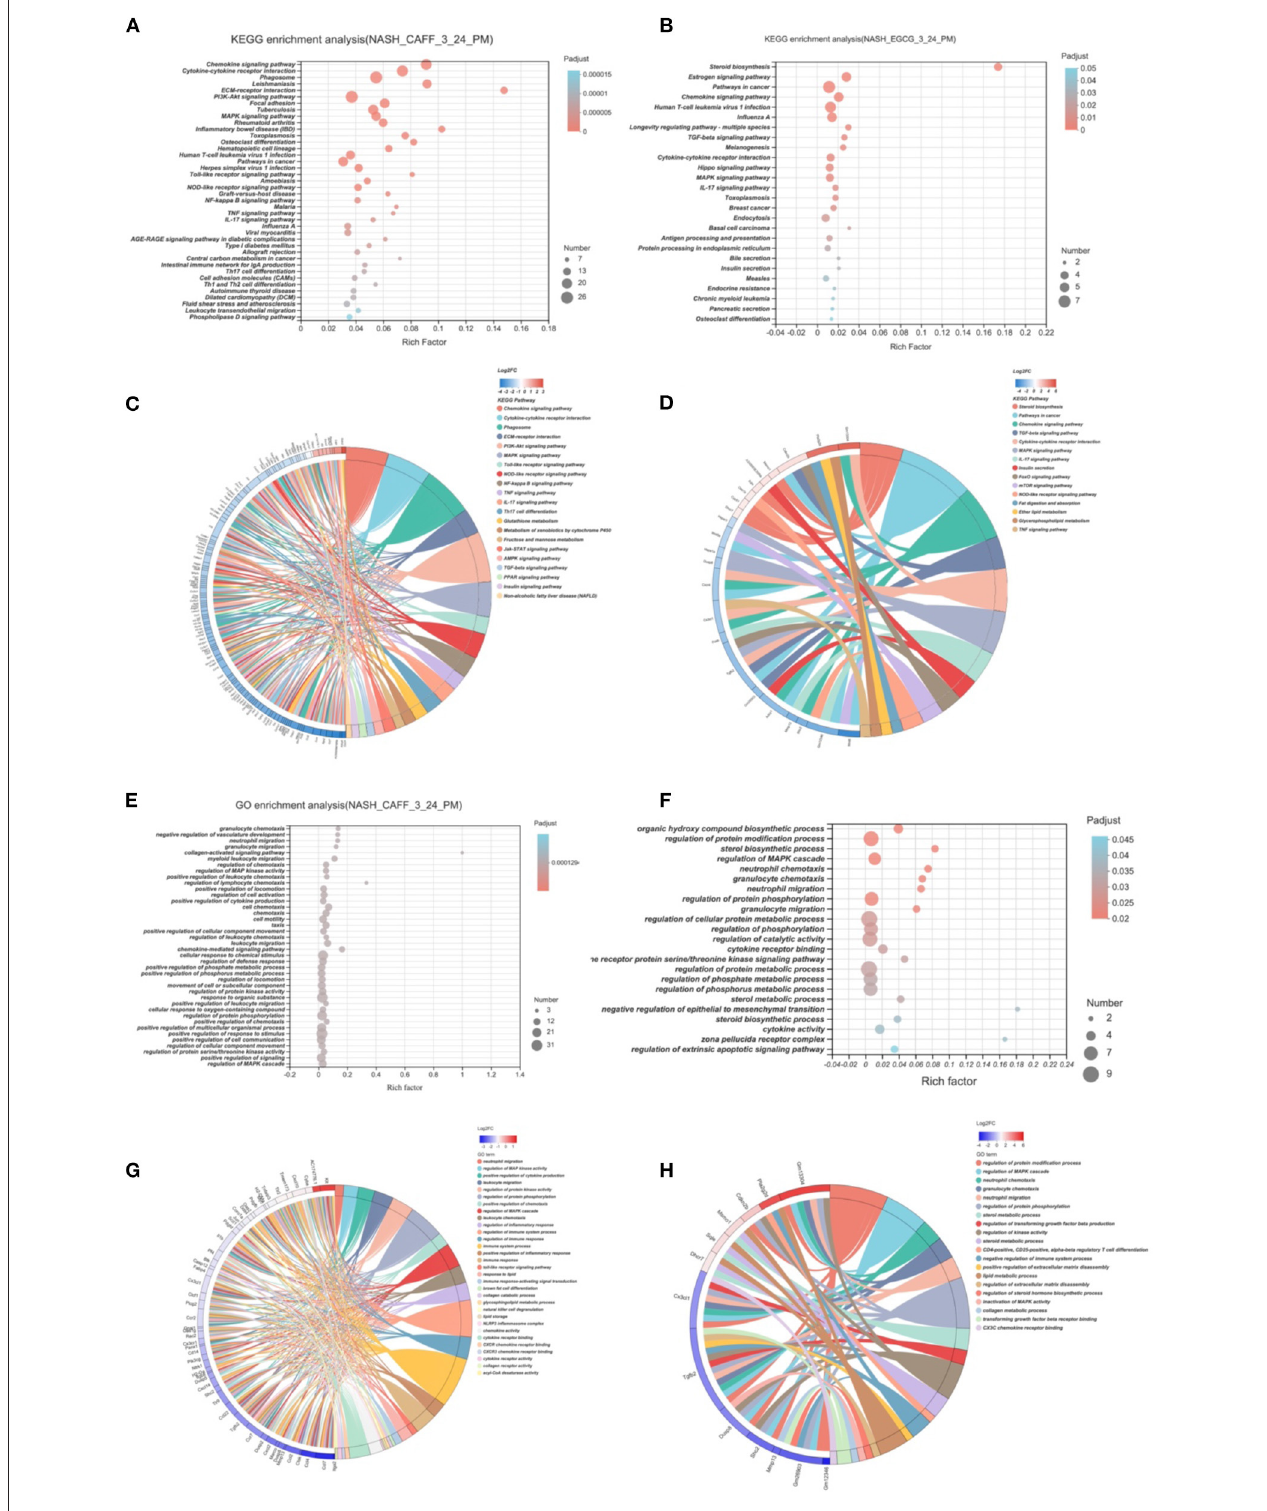
FIGURE 7 | Functional Enrichment Analysis of Caffeine and EGCG Gene Sets. Bubble graph of KEGG enrichment analysis of different genes of caffeine (A) and EGCG (B) compared with HFHC. KEGG enrichment analysis of caffeine (C) and EGCG (D) differential genes and enrichment circos graph of NASH related pathways. Bubble graph of GO enrichment analysis of different genes of caffeine (E) and EGCG (F) compared with HFHC. KEGG enrichment analysis of caffeine (G) and EGCG (H) differential genes and enrichment circos graph of NASH related pathways.